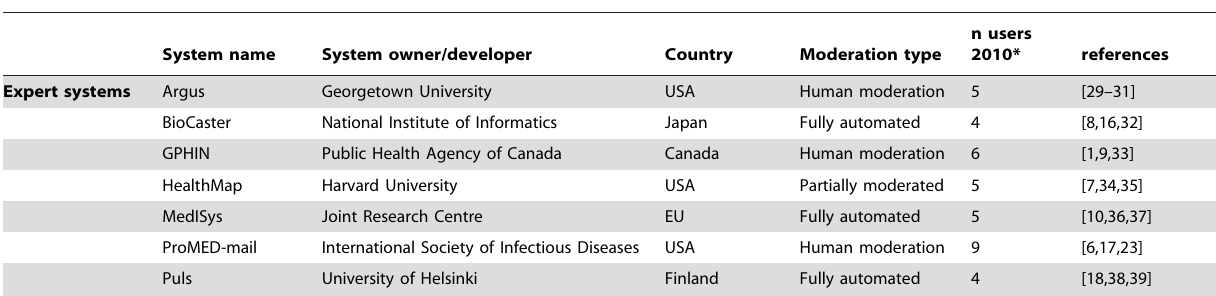
Table 1. Early Alerting and Reporting (EAR), participating